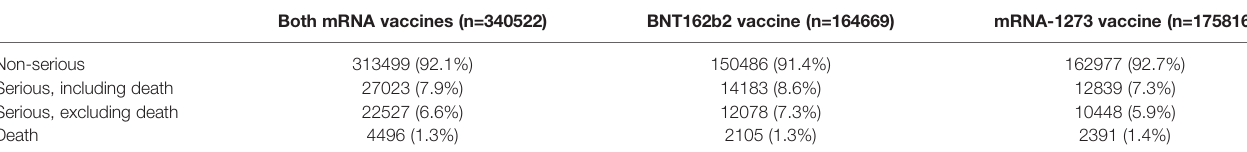
TABLE 3 | The results of the mRNA vaccine safety assessment. Both mRNA vaccines